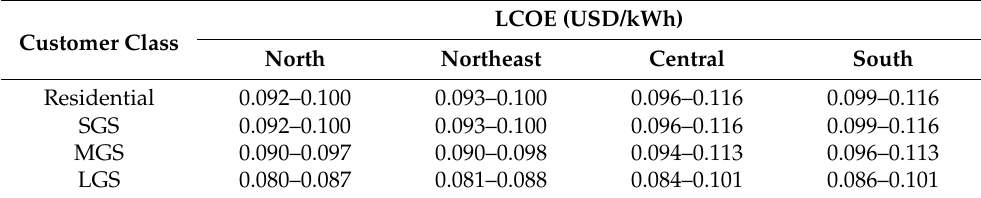
Table A6. Minimum and maximum LCOE by customer class and region.